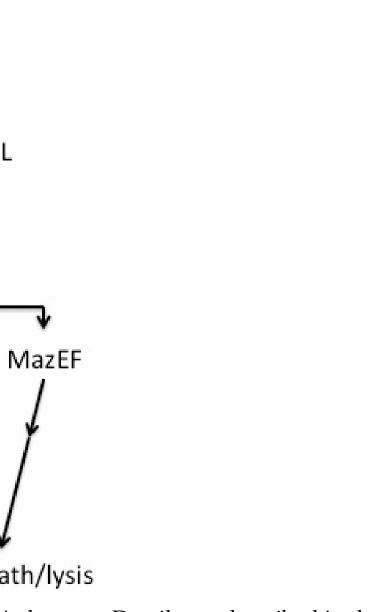
Figure 6. Pathways of SDCL following severe DNA damage. Details are described in the